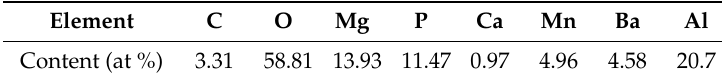
Table 1. The content of various elements in the film tested by EDS.